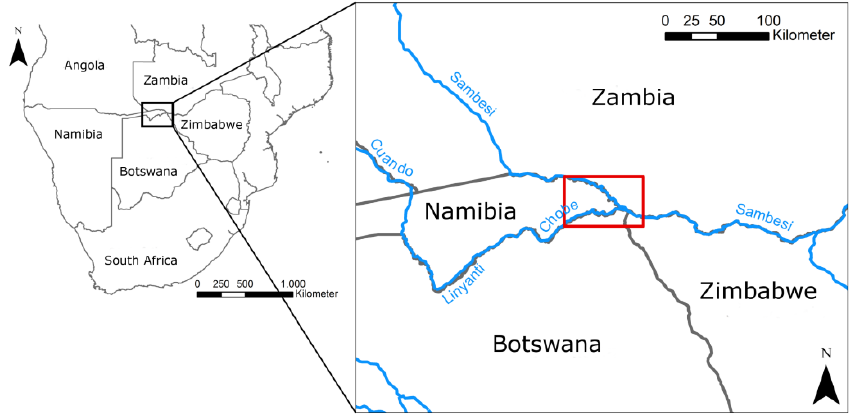
Figure 1. Location map of the study area (red rectangle) in Namibia.